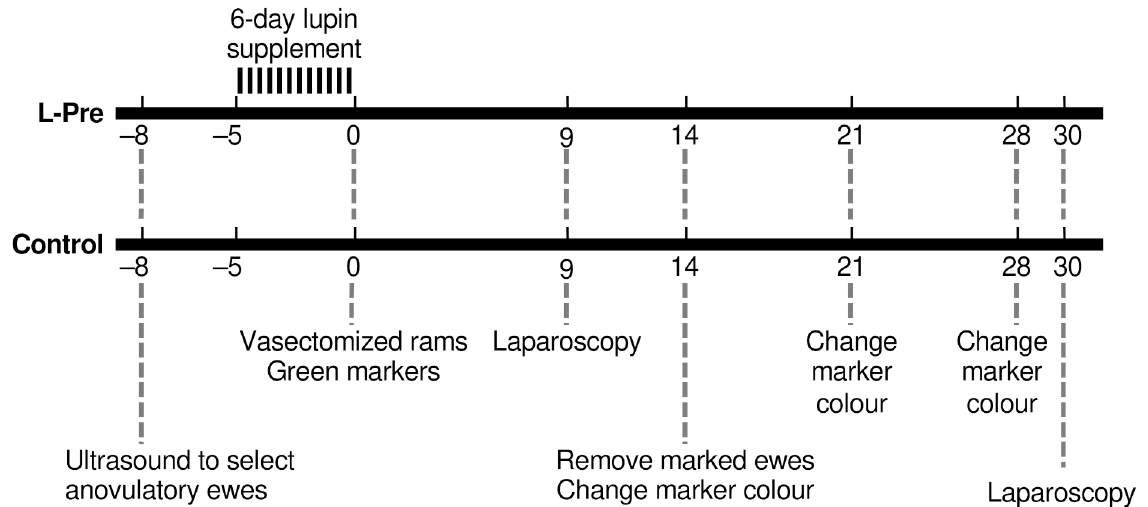
Figure 2. The protocol for Experiment 2. The Control and L-Pre groups were separated until Day 0 (the day males were